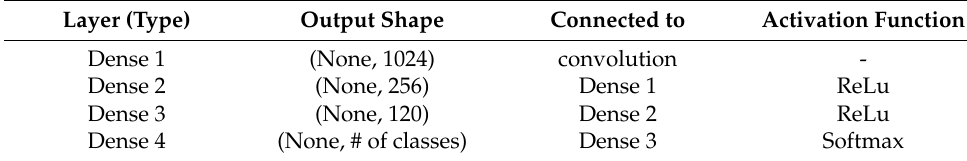
Table 3. Fully connected layer specification for the model.